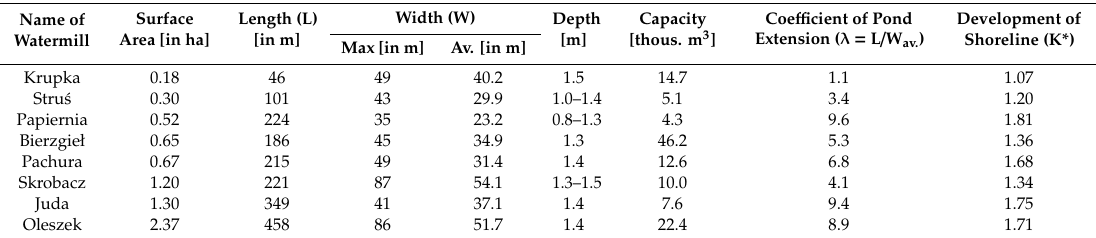
Table 1. Set of morphometric parameters of selected mill ponds with an average ponding level in the years 1872–1874